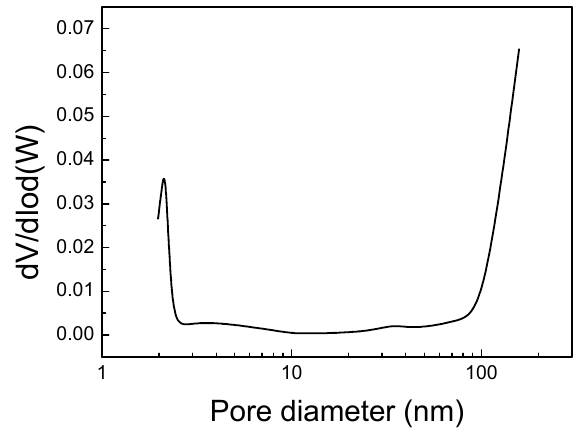
Figure 2. PMT curves for the blank solution (solid line) and the biochar suspension (dotted line). Inset: Consumption of H + ions by the surface as a function of suspension pH.